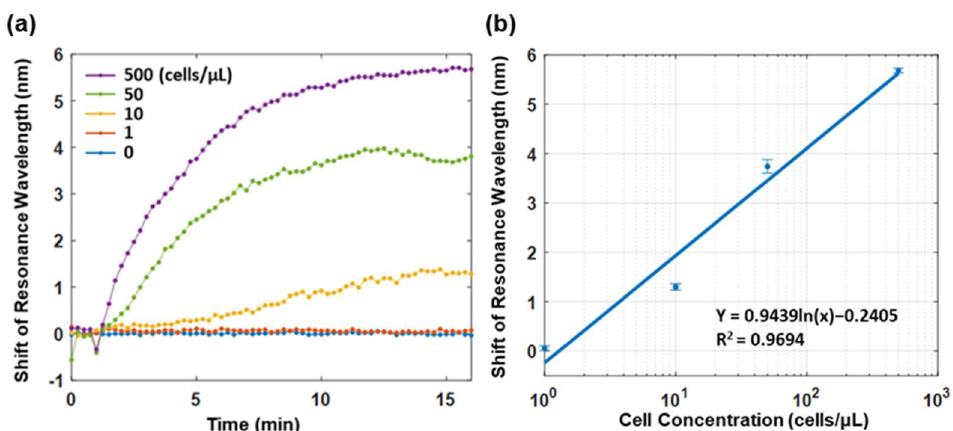
Figure 5. ( a ) SPR sensorgrams monitoring the relative shift of the resonance wavelength of the functionalized plasmonic fiber probe in PBS flow of different MCF-7 cell concentrations in real time. ( b ) The logarithm fitting of the wavelength shifts of SPR dip versus variant MCF-7 cell concentrations. The data points denote the relative shift of resonance wavelength recorded at the end of a 15 min enrichment in each sample. The error bar shows the standard deviation of data points in one minute before the end of enrichment.